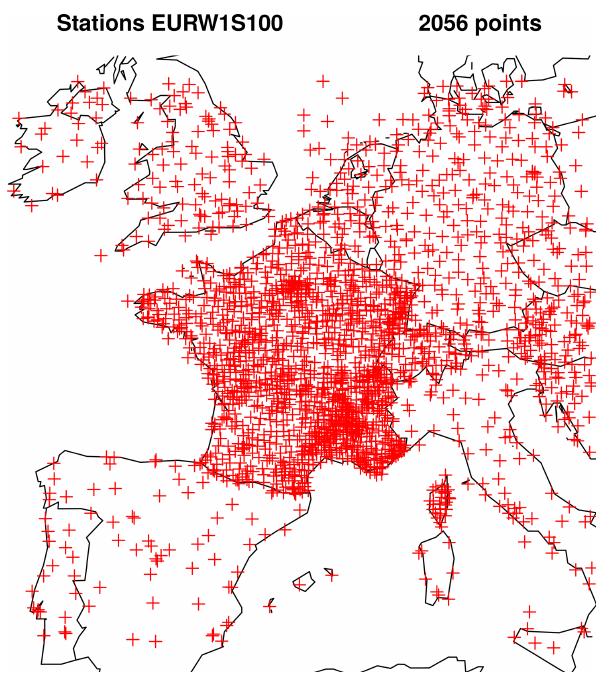
Figure 3. Localization of stations on the target grid.